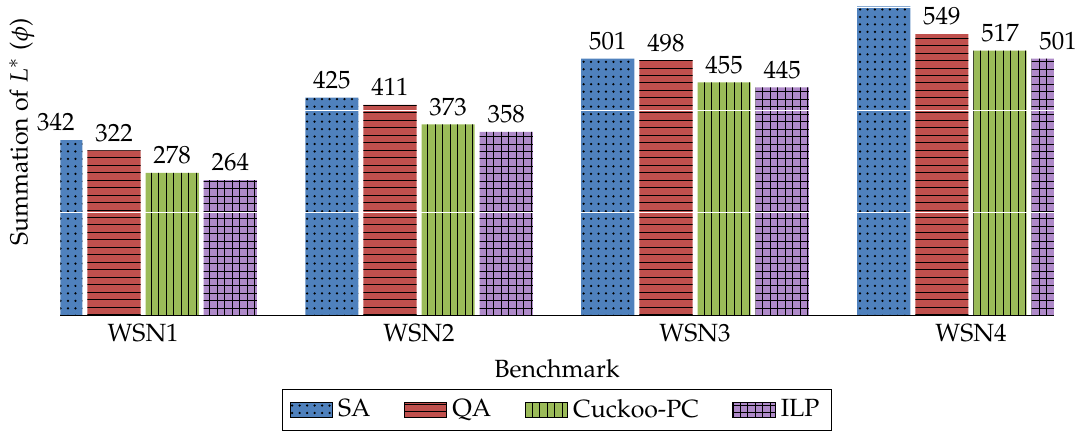
Figure 4. The summation of L ∗ for all nodes ( φ ). (The average value over 30 runs of the algorithms).